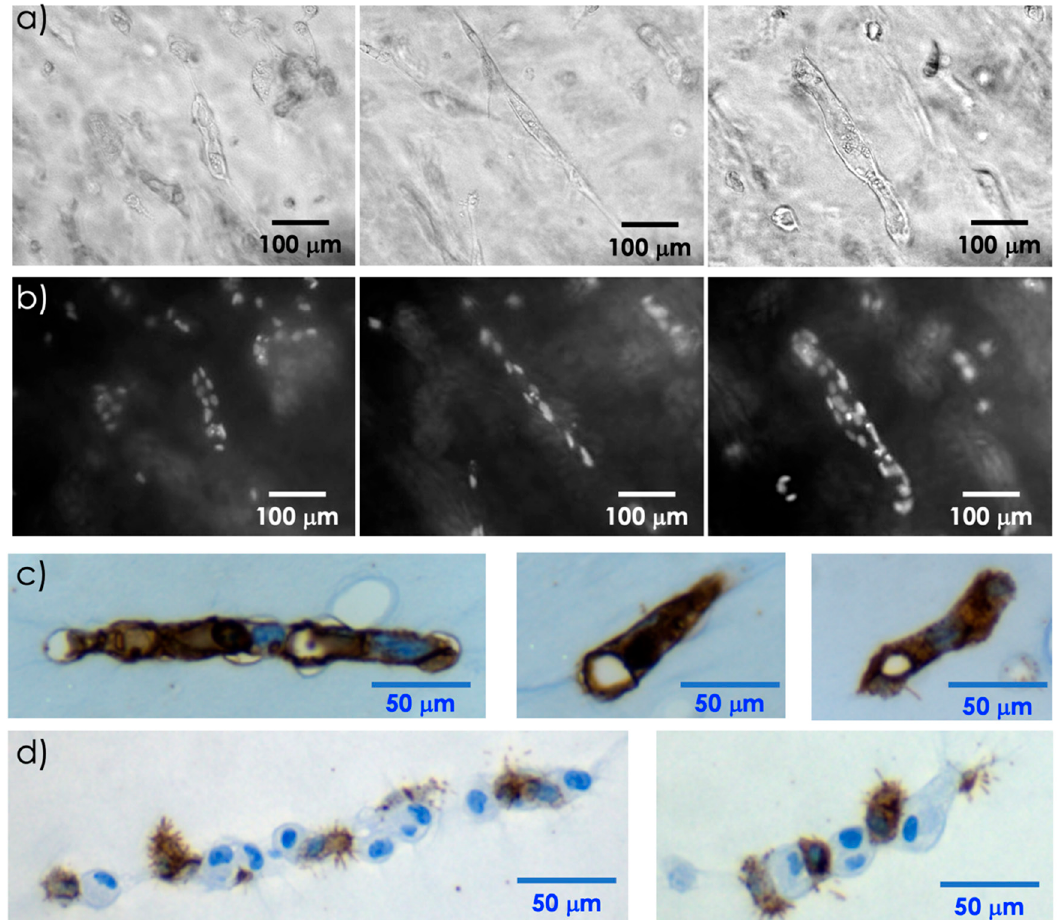
Figure 9. Aligned endothelial cells in fibrin clot at 96 h ( a ). DAPI staining showing cellular nuclei ( b ). CD31 (clone PECAM-1) staining of clot-entrapped human umbilical vein endothelial cells (HUVECs) ( c ). CD31 staining of clot-entrapped HUVECs and hMSCs ( d ).